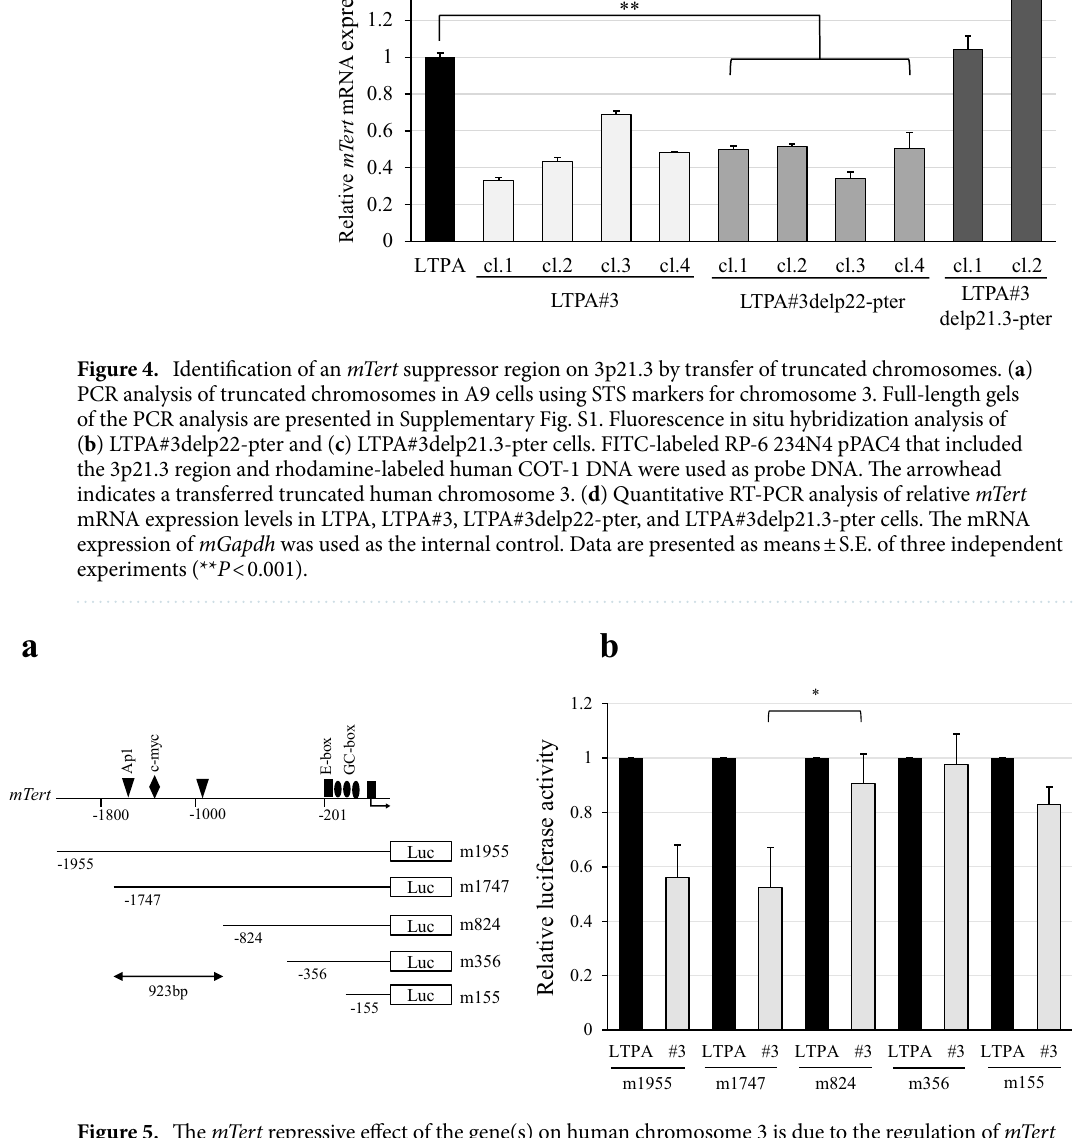
Figure 5. The mTert repressive effect of the gene(s) on human chromosome 3 is due to the regulation of mTert promoter activity. ( a ) The schema shows the truncation sites of the mTert promoter for each of the luciferase (Luc) reporter plasmids. ( b ) The luciferase activity was standardized using Renilla reniformis luciferase activity from a co-transfected pGL4.70 plasmid. Data are presented as means ± S.E. of three independent experiments (* P =